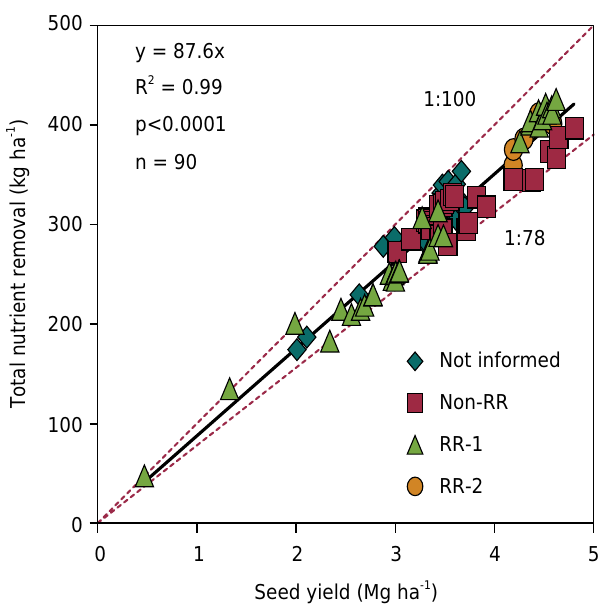
Figure 4. Relationship between soybean yield and the total removal of macronutrients in soybean seeds. Solid black line represents a positive slope (p<0.05). Graphs were generated using all available data from field experiments containing all six nutrients content in soybean seeds and the soybean yield from 1974 to 2019. Dotted lines indicate boundaries for maximum and minimum ratio for each